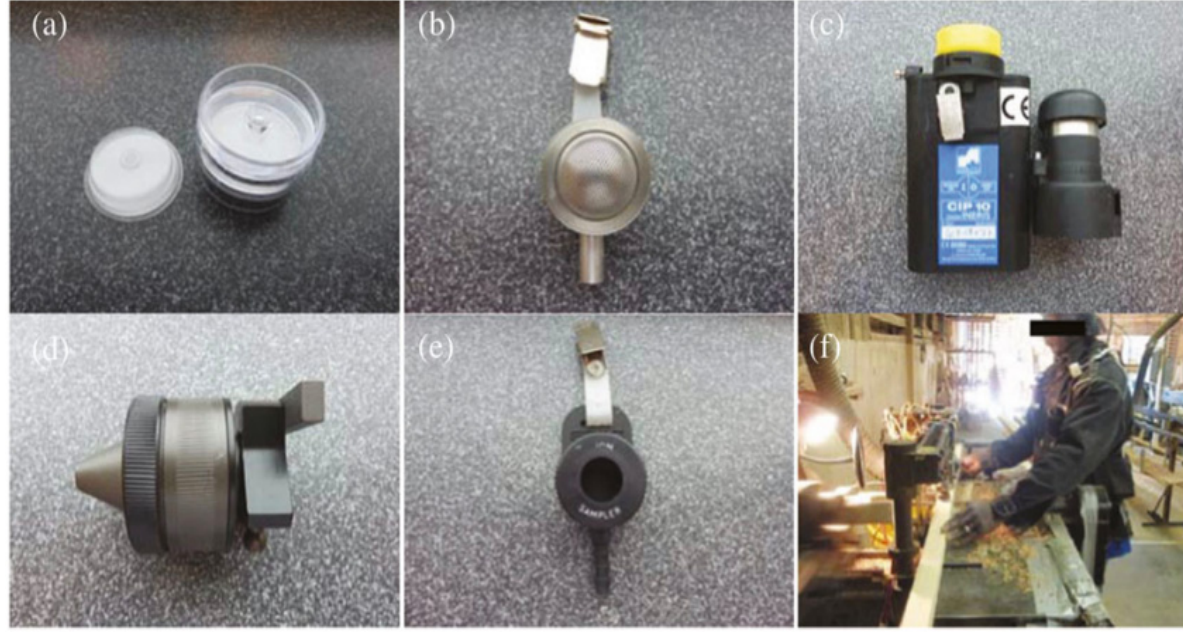
Figure 2. ( a ) ACCU-CAP™ sampler, ( b ) Button sampler, ( c ) CIP10-I sampler, ( d ) GSP sampler, ( e ) IOM sampler, and ( f ) wood dust sampling with the worker wearing the ACCU-CAP™ sampler and the CIP10-I sampler. From Figure 1 (Tested aerosol samplers) in Lee et al. [35] licensed under Creative Commons CC BY.